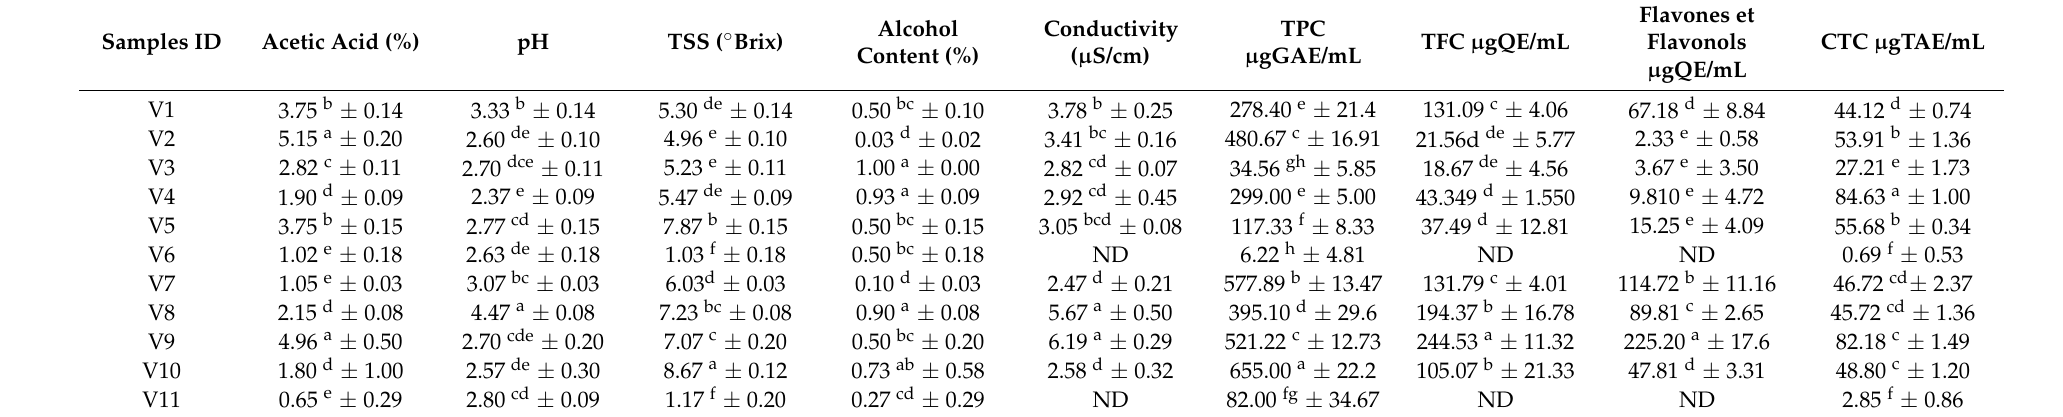
Table 1. Physicochemical properties and bioactive compounds of different vinegar samples.